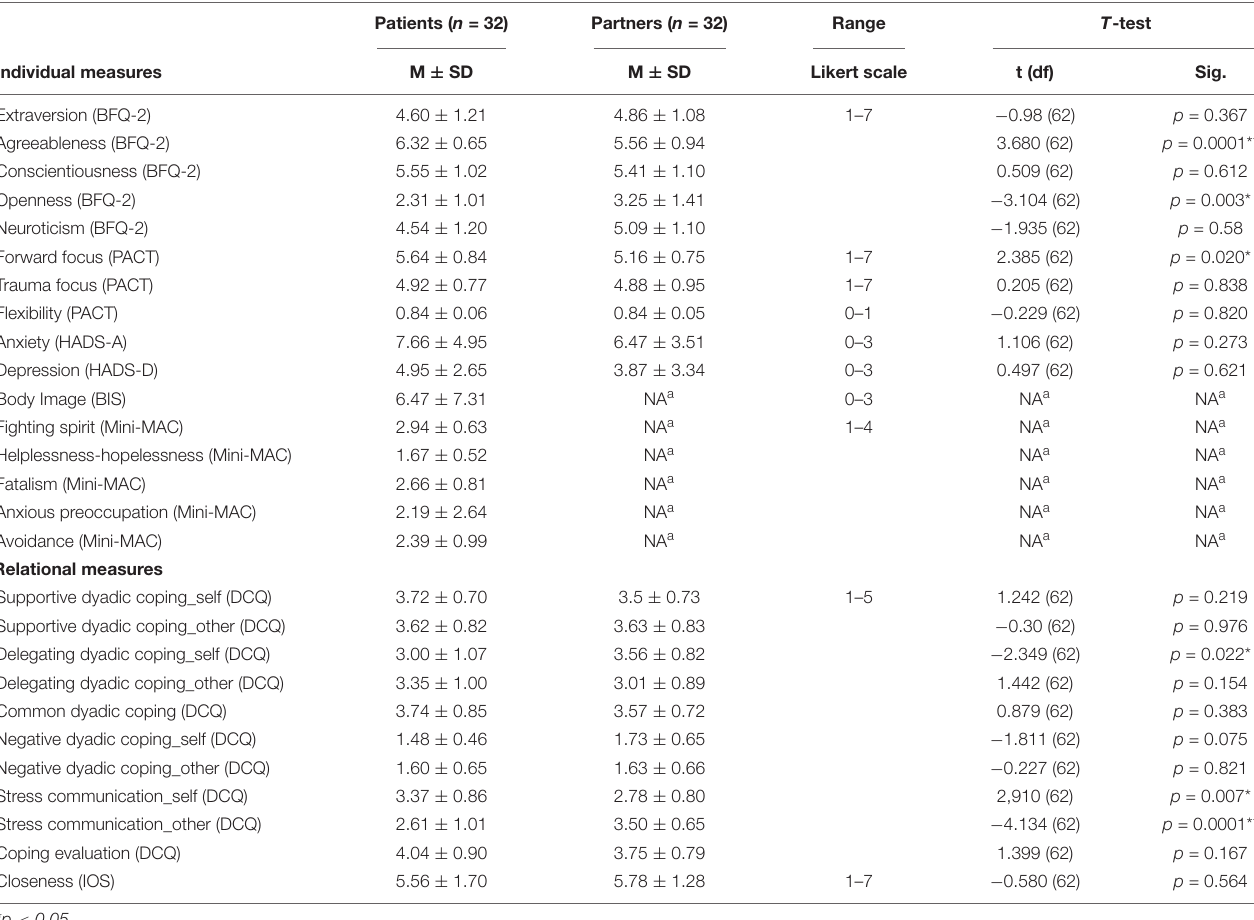
TABLE 2 | Descriptive statistics of individual and relational measures by role (patients vs. partners).